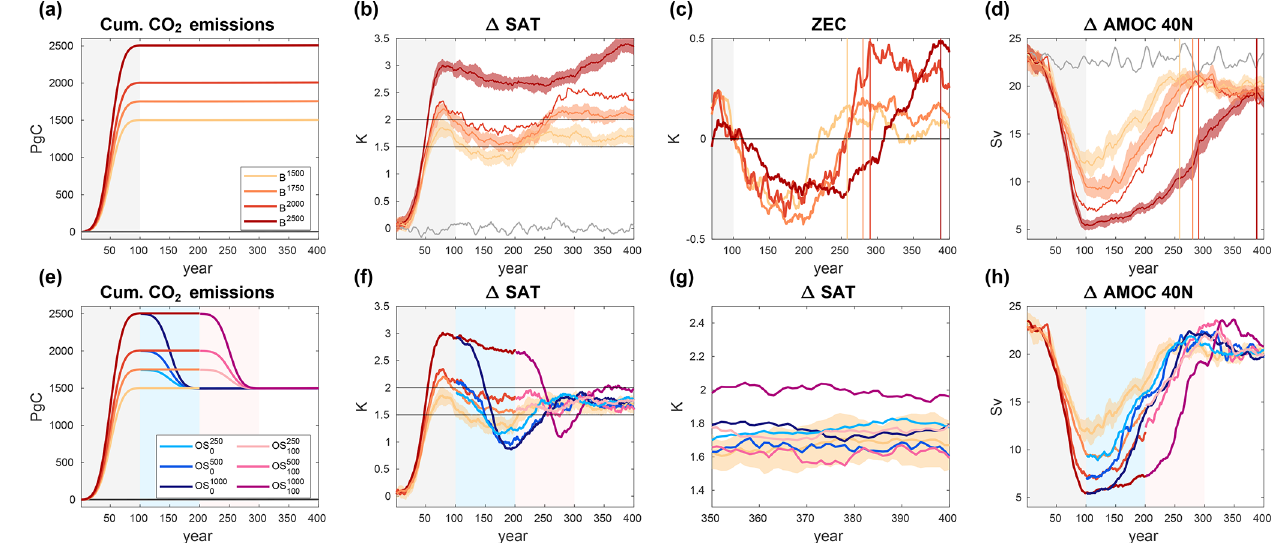
Figure 1. Cumulative carbon emissions (a, e) , global average surface temperature change (b, c, f, g) , and change in AMOC strength (d, h) . For clarity, panels (a) – (d) show ensemble means for the B simulations only (as indicated in the legend in panel a ) with positive emissions for 100 years and zero emissions thereafter, while panels (e) – (h) show ensemble means for the overshoot simulations branched from the B simulations (as indicated in the legend in panel e ). Panel (c) shows global average mean temperature change relative to the point in time when emissions cease, and panel (g) provides a zoom into the last 50 years of the SAT evolution shown in panel (f) . The vertical lines in panels (c) and (d) indicate the time of the secondary SAT maximum, and the shading around the ensemble means indicates an estimate of internal variability as described in the text. An 11-year moving average filter has been applied to the time series displayed in panels (b) – (d) and (f) – (h) . The shaded areas in the background indicate the different phases of the simulations (grey: positive emissions; light blue: negative emissions for the short overshoots; light red: negative emissions for the long